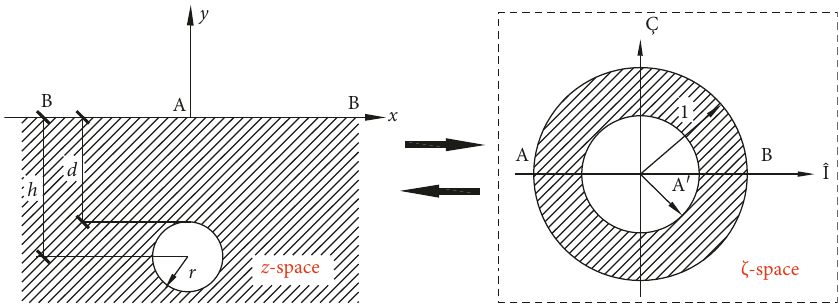
Figure 1: Conformal transformation for shallow tunnel, reproduced from